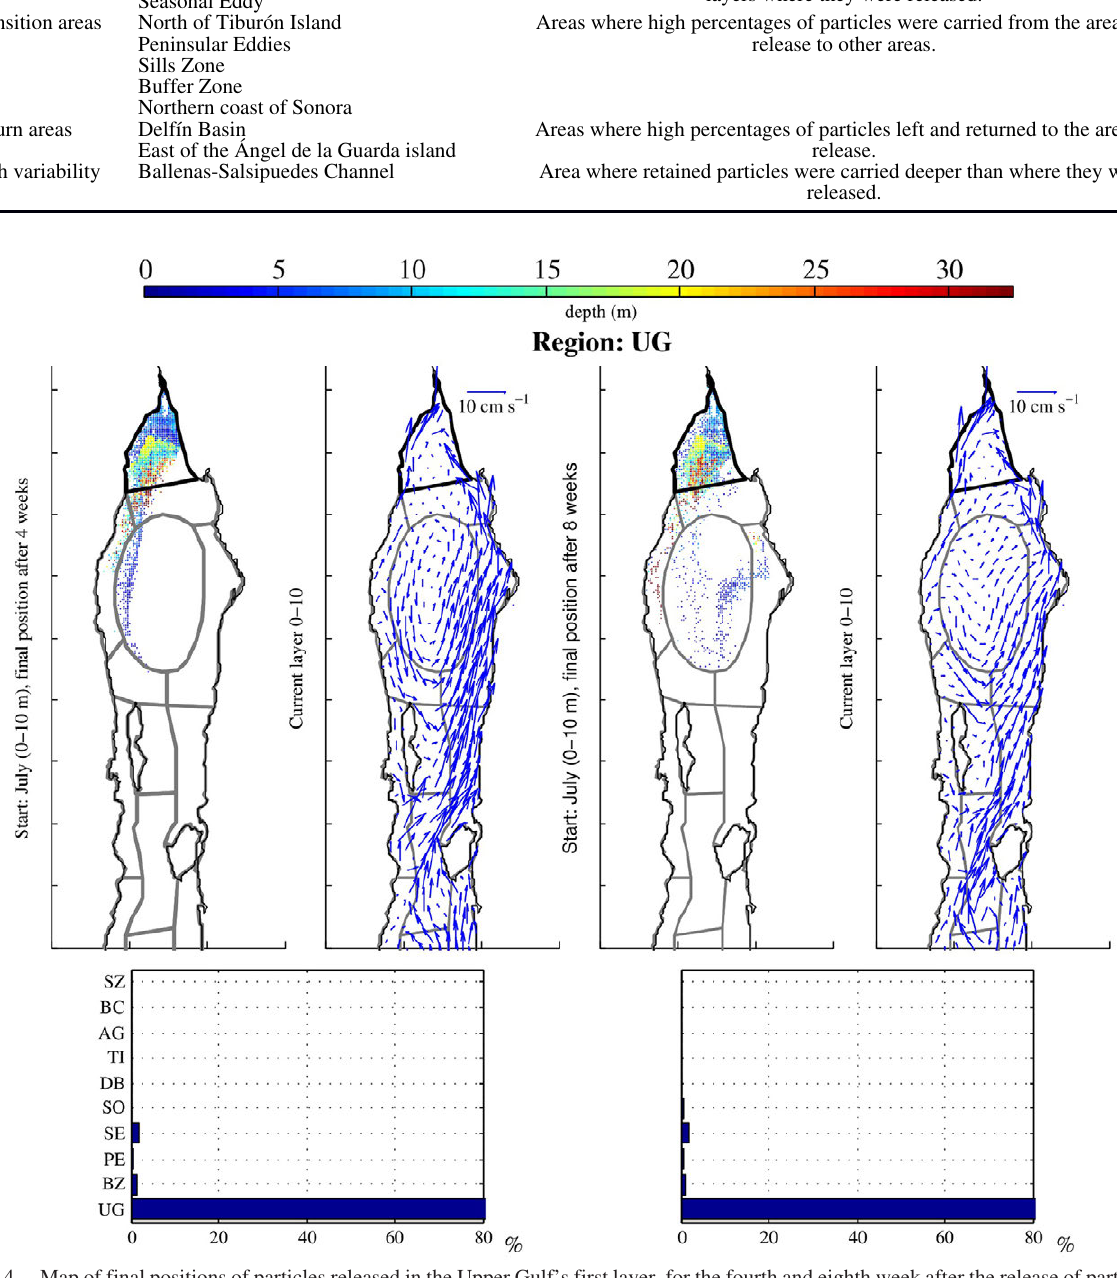
Fig. 4. – Map of final positions of particles released in the Upper Gulf’s first layer, for the fourth and eighth week after the release of particles. The release area is shown in black and the other areas in grey polygon. The colour bar represents the depth at which each particle is located. The histogram shows the percentage of particles retained or transferred to other regions. Current maps correspond to the layer in which the percentage of particles retained is concentrated, in the fourth and eighth week after particle